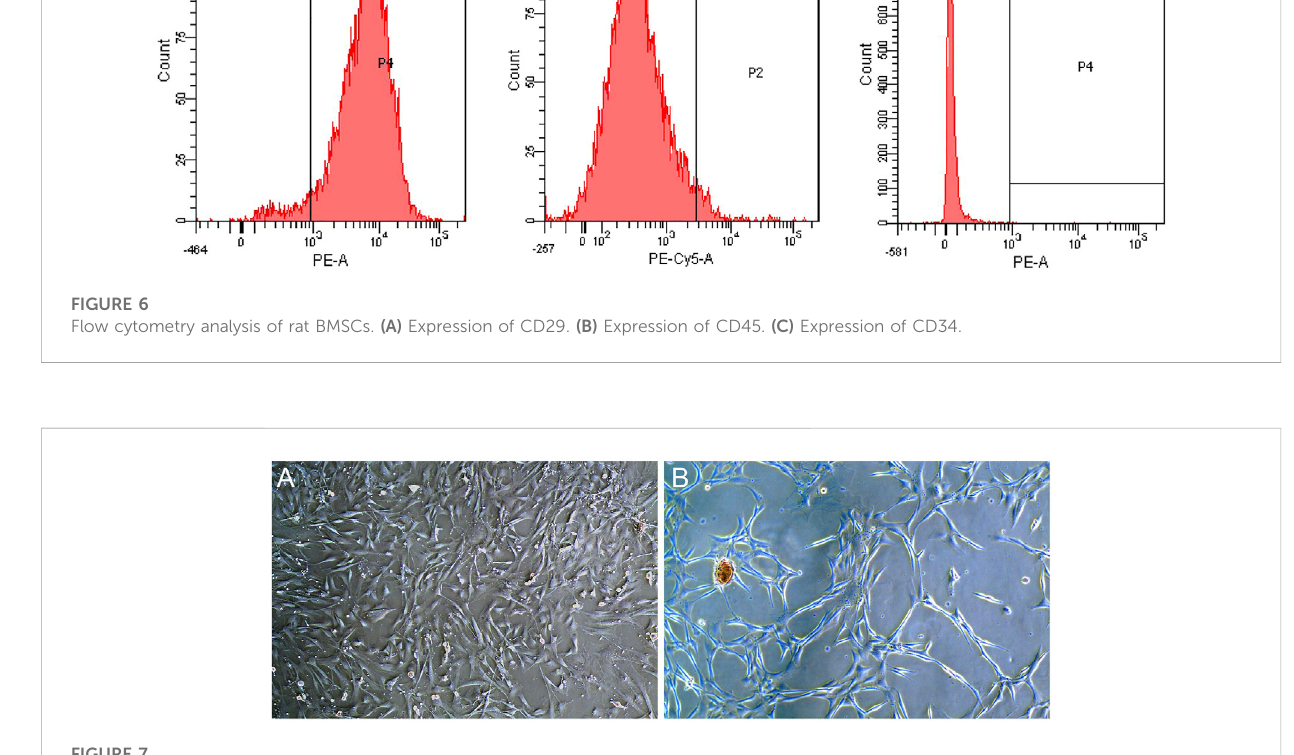
FIGURE 7 Photos of rrPDGF-BB induced BMSCs (X50). (A) One days after intervention. (B) Three days after